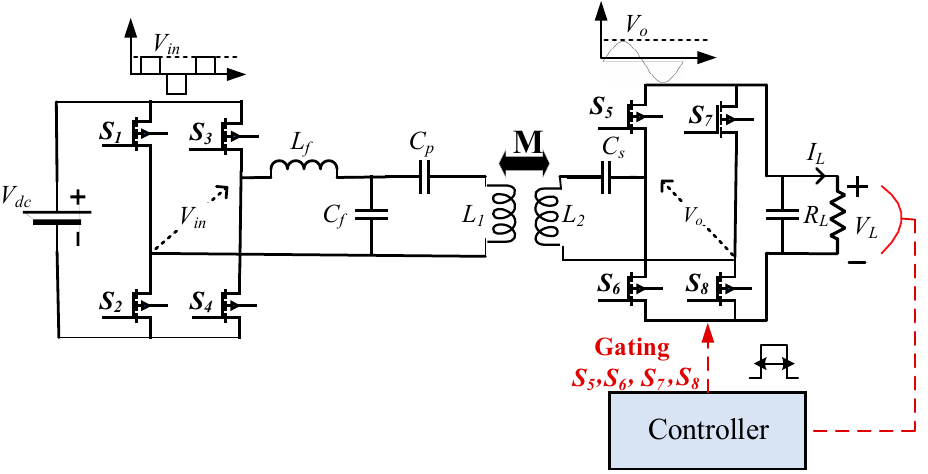
Figure 26. Receiver side full-bridge active rectifier control for a WPT system.